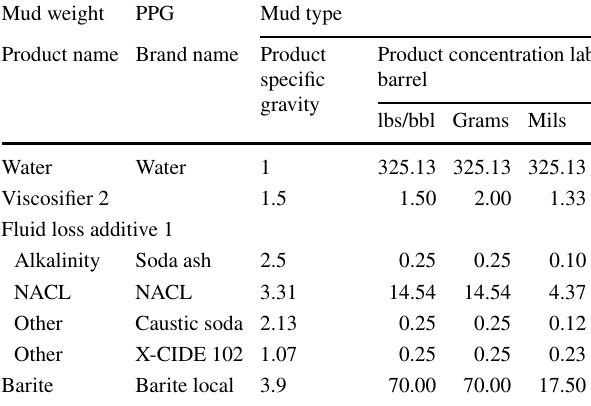
Table 3 Water-based mud systems (aqueous) formulation Mud weight